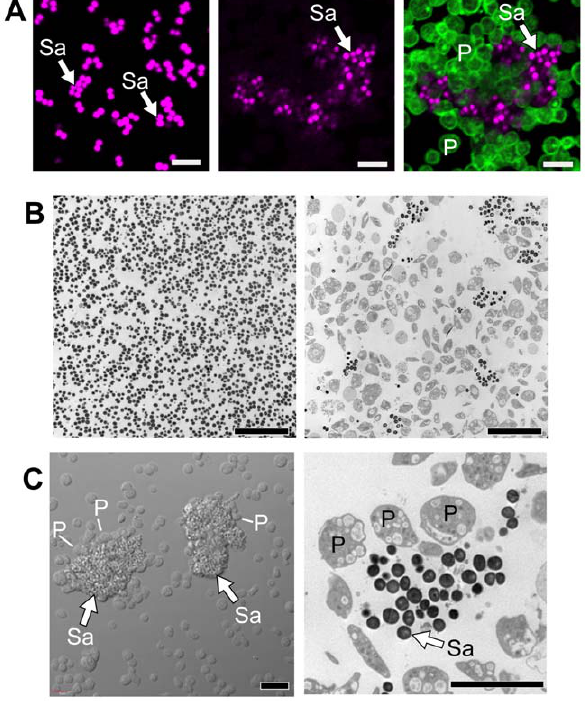
Figure 1. Platelets sequester S.aureus . Cultured S. aureus were incubated in the presence or absence of platelets (240 minutes). At the end of this period, an equal volume of fixative was added to the suspension and the samples were prepared for confocal (A) or transmission electron (B) microscopy. (A) The left panel shows S. aureus (magenta - stained with topro-3) only. The middle panel displays the pattern of S. aureus (magenta) growth in the presence of platelets, which are not visible in this panel but shown in an overlay that is displayed in the far right panel (bacteria, magenta; platelets, green – stained with phalloidin). Scale bars=5 m m. (B) Transmission electron microscopy of S. aureus in the presence (right panel) or absence (left panel) of platelets. Scale bars=10 m m. (C) Differential interference contrast (left panel) and transmission electron (right panel) microscopy of clusters of S. aureus (arrows) surrounded by platelets. Scale bars=5 m m. The panels in figure 1 are representative of three to four independent experiments. Sa, S. aureus ; P,